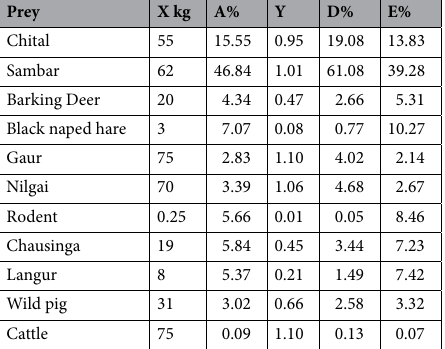
Table 1. Average live weight of prey consumed (X), frequency of occurrence (A), weight of consumed prey represented by one field-collectible scat using correction factor (Y), relative biomass consumed (D), and relative number of prey individuals consumed (E) by dholes based on scats collected across the study sites in Maharashtra, India (n =